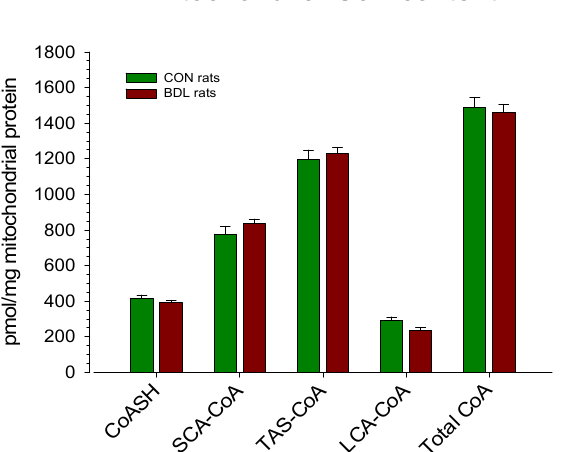
Figure 1. Mitochondrial CoA content. Rats were bile duct ligated for 4 weeks (BDL rats, n = 9) or sham-operated control rats ( n = 5). After euthanasia by cervical dislocation, the liver was removed and homogenized. Mitochondria were isolated from the homogenate by serial centrifugation. The CoA content was determined in isolated mitochondria using a radioenzymatic method, as detailed in Methods. Data are presented as the mean ± SEM.